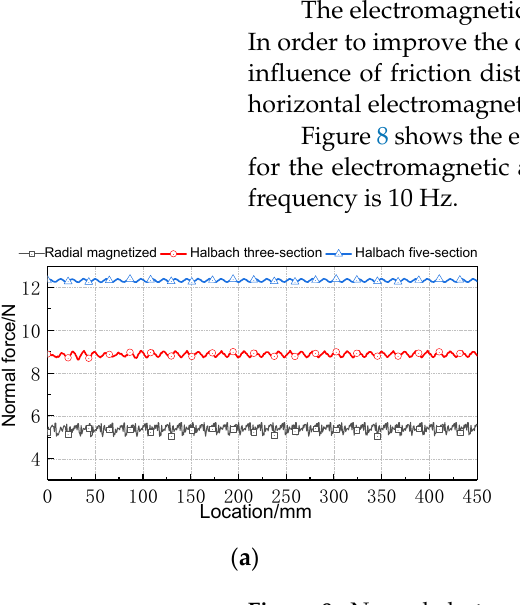
Figure 8. Normal electromagnetic force: ( a ) Unilateral normal force; ( b ) Bilateral combined normal force.